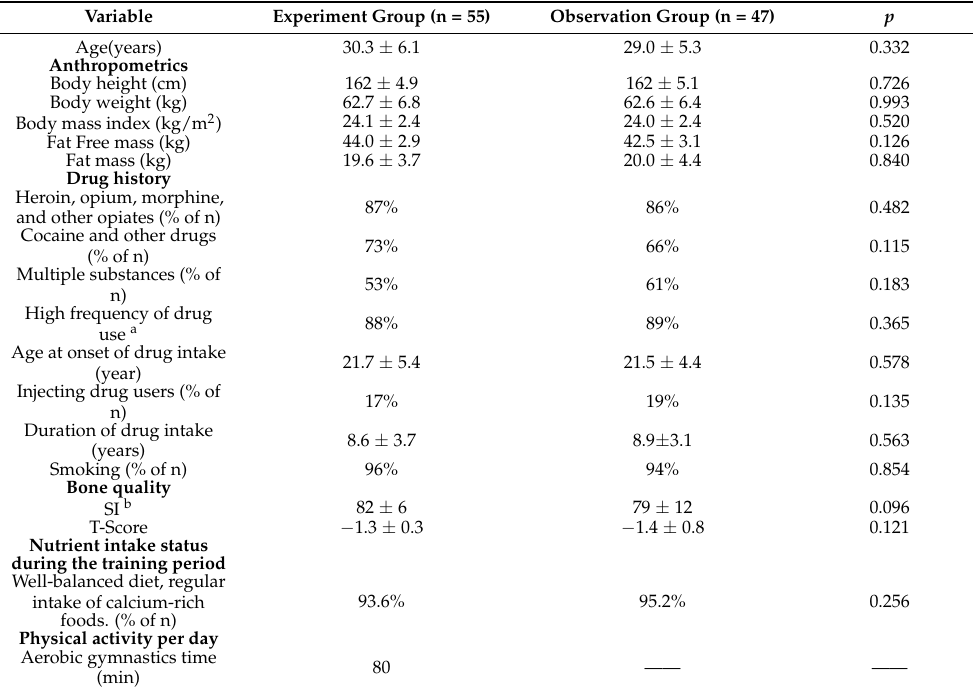
Table 2. Baseline characteristics of the low bone quality intervention experimental group and low bone quality observation control